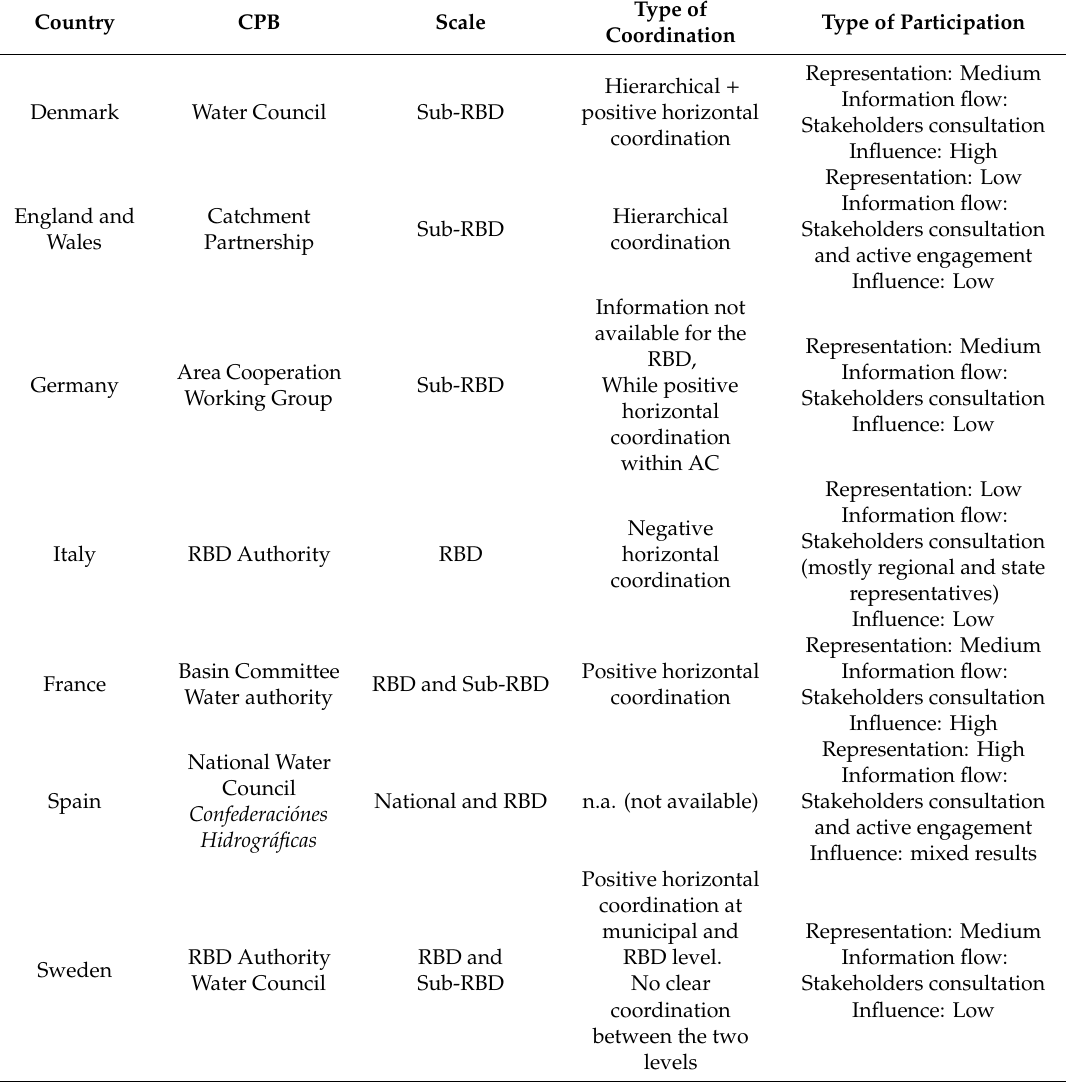
Table 2. Summary of the main results based on the conceptual framework provided in Table